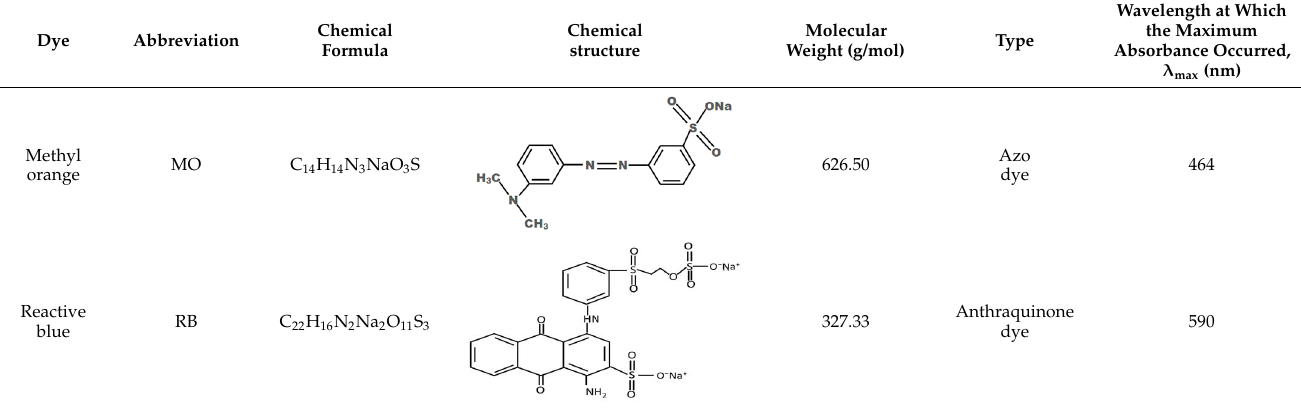
Table 1. Physio-chemical properties of the dyes used in this study.